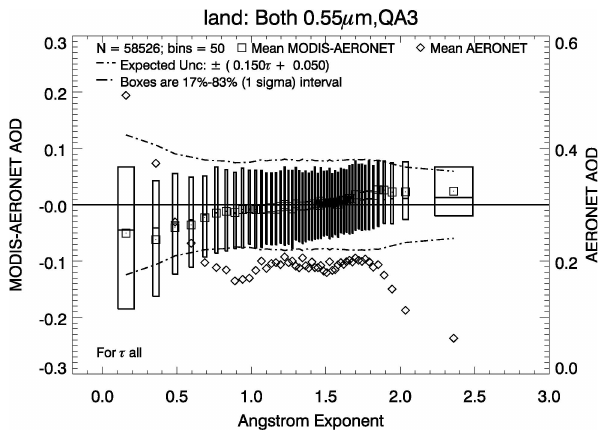
Fig. 6. Differences between MODIS and AERONET-reported AOD at 0.55µm (MODIS-AERONET) vs. AERONET-observed AE, for QAC=3. Data are sorted by the AE and grouped into 50equal bins. Each box represents the statistics of the MODIS-AERONET dif- ferences in the bin. The means and standard deviations of the AE (each bin) are the centers and half widths in the horizontal. The mean, medians, and 66% (1- σ ) interval of the MODIS-AERONET differences are the squares, the center, and top-bottom intervals of the boxes. The dashed curves represent the over-land EE enve- lope for total AOD ± (0.05+0.15), where EE is calculated based on the mean AERONET AOD within the bin (diamonds; right y-axis